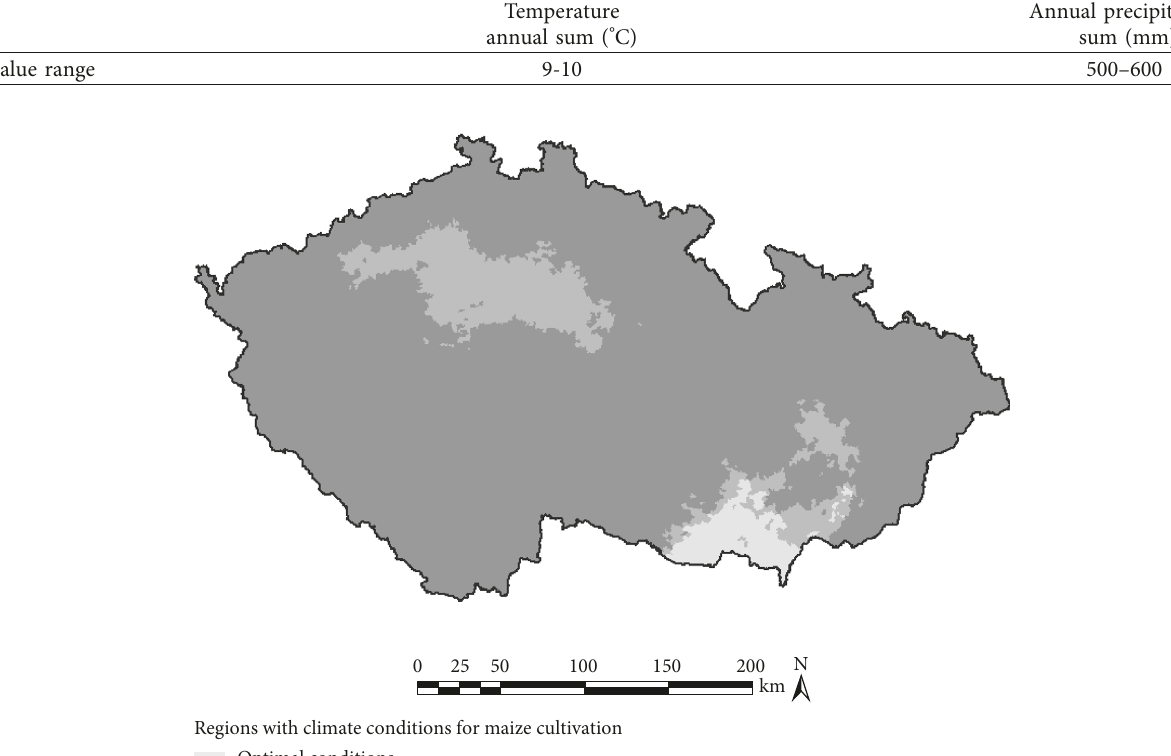
Figure 2: Climate conditions for grain maize growing in the study region of the Czech Republic in